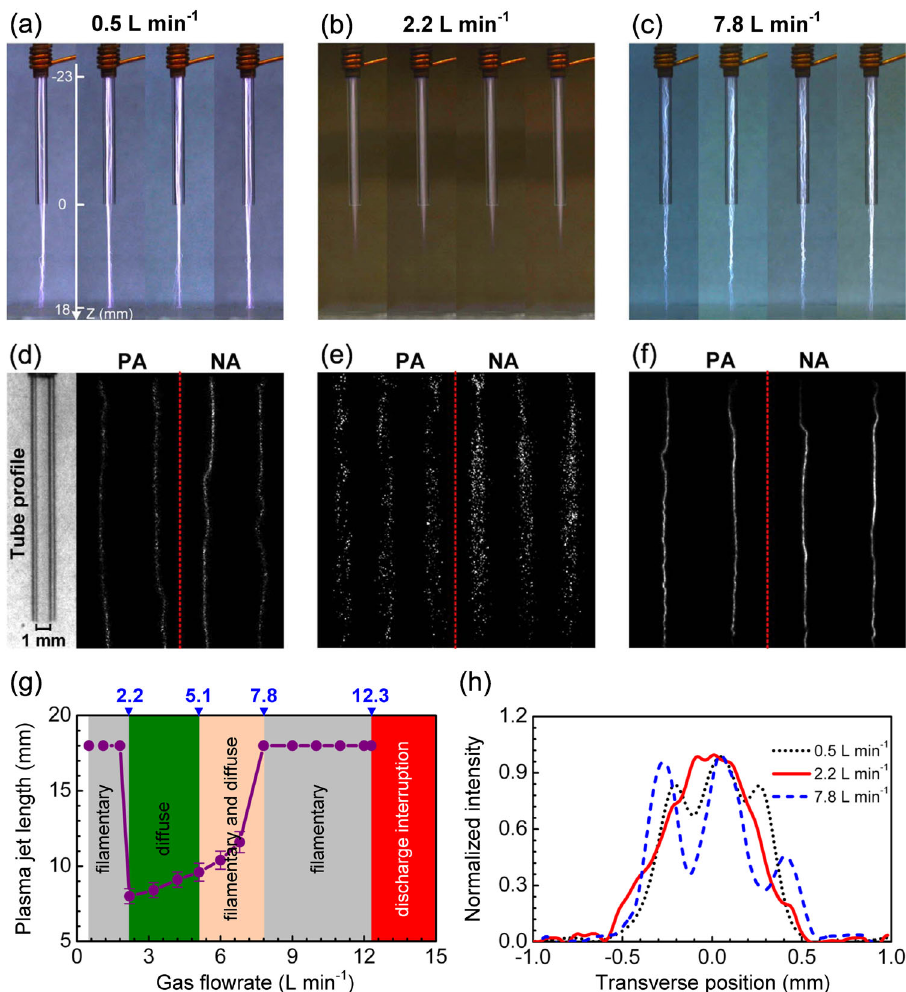
Fig. 3 Physical appearances of the plasma jet. a Typical images of the plasma jet acquired by a digital camera with the gas fl owrate fi xed at 0.5 l min − 1 at four different moments. The plasma jet extends along the z -axis, with its length of 18 mm. The exposure time is 10 ms. b Same as a , but with the gas fl owrate fi xed at 2.2 l min − 1 at four different moments. c Same as a , but with the gas fl owrate fi xed at 7.8 l min − 1 at four different moments. d Typical images of the plasma jet captured by a fast intensi fi ed charge-coupled device (ICCD) camera with the gas fl owrate fi xed at 0.5 l min − 1 at four random current pulses for both the positive alternation (PA) and negative alternation (NA), as well as the tube pro fi le without discharge. Images in PA and NA are separated by the red dashed line. The gate width is 4 μ s. e Same as d , but with the gas fl owrate fi xed at 2.2 l min − 1 at six random current pulses for both PA and NA. f Same as d , but with the gas fl owrate fi xed at 7.8 l min − 1 at four random current pulses for both PA and NA. g Plots (purple solid circle) of the plasma jet length as a function of the gas fl owrate. Within the fl owrate range from 2.2 to 7.8 l min − 1 , the plots show an average of fi ve experimental measurements, and the measurement uncertainty (one standard deviation) is indicated by the error bars and is estimated to be 5 – 7%. The shaded regions are introduced in order to focus the attention on the variation of discharge mode with the gas fl owrate, i.e., gray shadow for the fi lamentary discharge, green shadow for the diffuse discharge, orange shadow for the mixing mode of fi lamentary and diffuse discharge, and red shadow for the discharge interruption. h Spatial distributions of light intensity of discharge along the transverse direction at the distance of 1 mm away from the nozzle for the gas